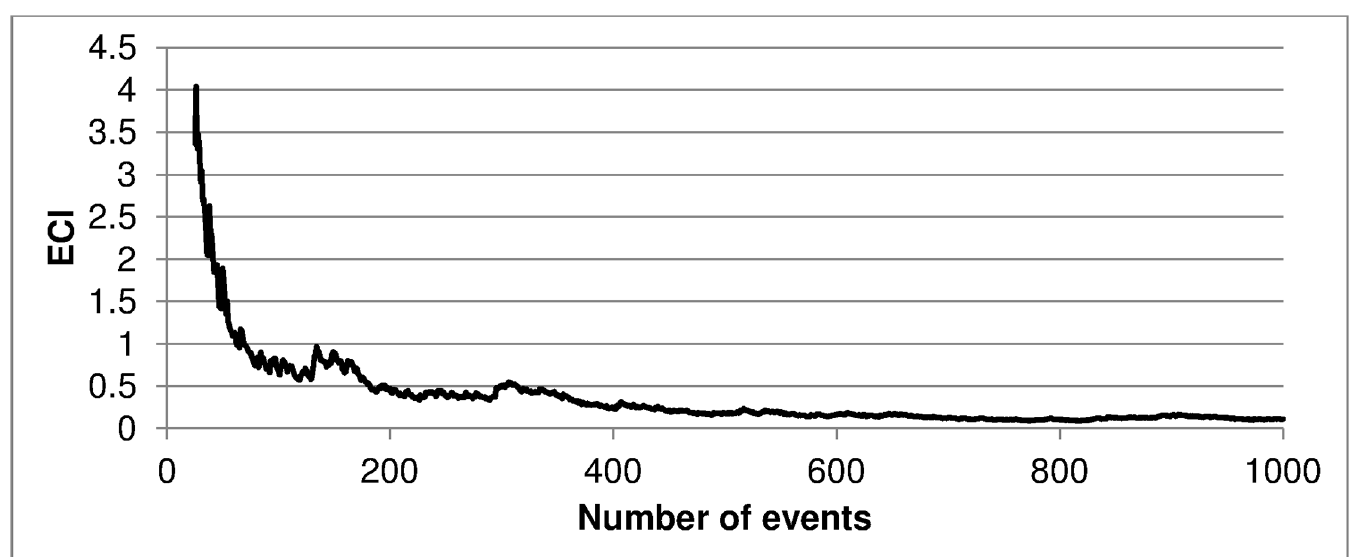
Fig 2. Estimated calibration index values according to the number of events in the sample. ECI, estimated calibrationindex.